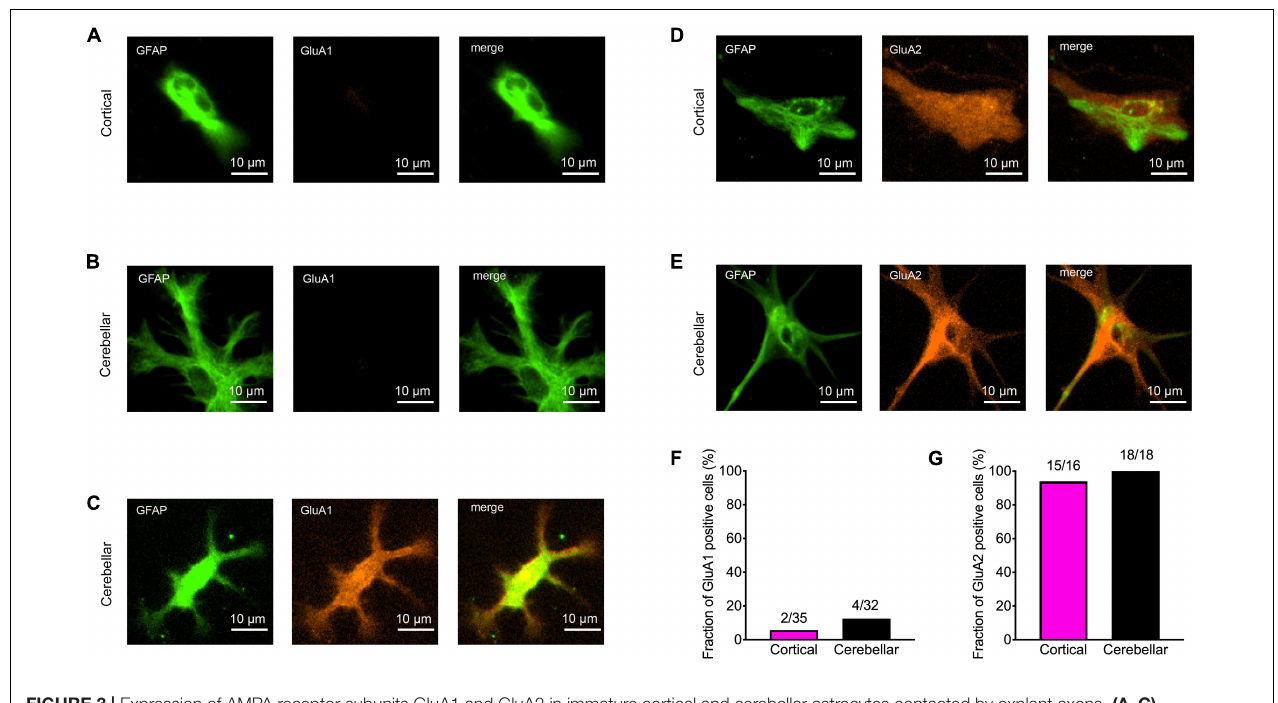
FIGURE 3 | Expression of AMPA receptor subunits GluA1 and GluA2 in immature cortical and cerebellar astrocytes contacted by explant axons. (A–C) Co-immunostainings for GFAP (green) and GluA1 (red) in immature cortical astrocytes (A) and in cerebellar astrocytes (B,C) . Scale bars: 10 µ m. (D,E) Co-immunostainings for GFAP (green) and GluA2 (red) in immature cortical astrocytes (D) and in cerebellar astrocytes (E) . (F,G) Quantification of GluA1 (F) and GluA2 (G) positive astrocytes contacted by explant